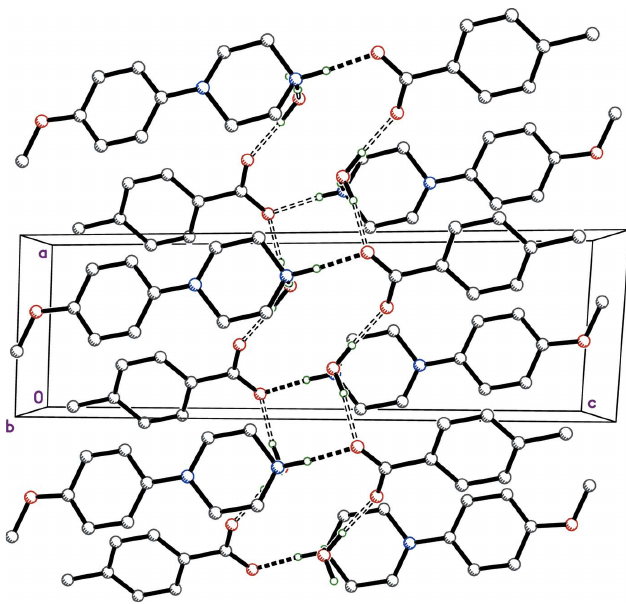
Figure 9 A packing plot of IV viewed down the b -axis, showing N—H (cid:2)(cid:2)(cid:2) O (solid dashes) and O—H (cid:2)(cid:2)(cid:2) O (open dashes) hydrogen bonds, which form bi- layered tapes in the ac plane that extend parallel to a . Hydrogen atoms not involved in hydrogen bonds are ecules. The asymmetric units are linked by O—H (cid:2) (cid:2) (cid:2) O hydrogen bonds to glide-related ( x , 1 1 + z ) equivalents parallel to c (Figs. 3 and 8). These connec- 2